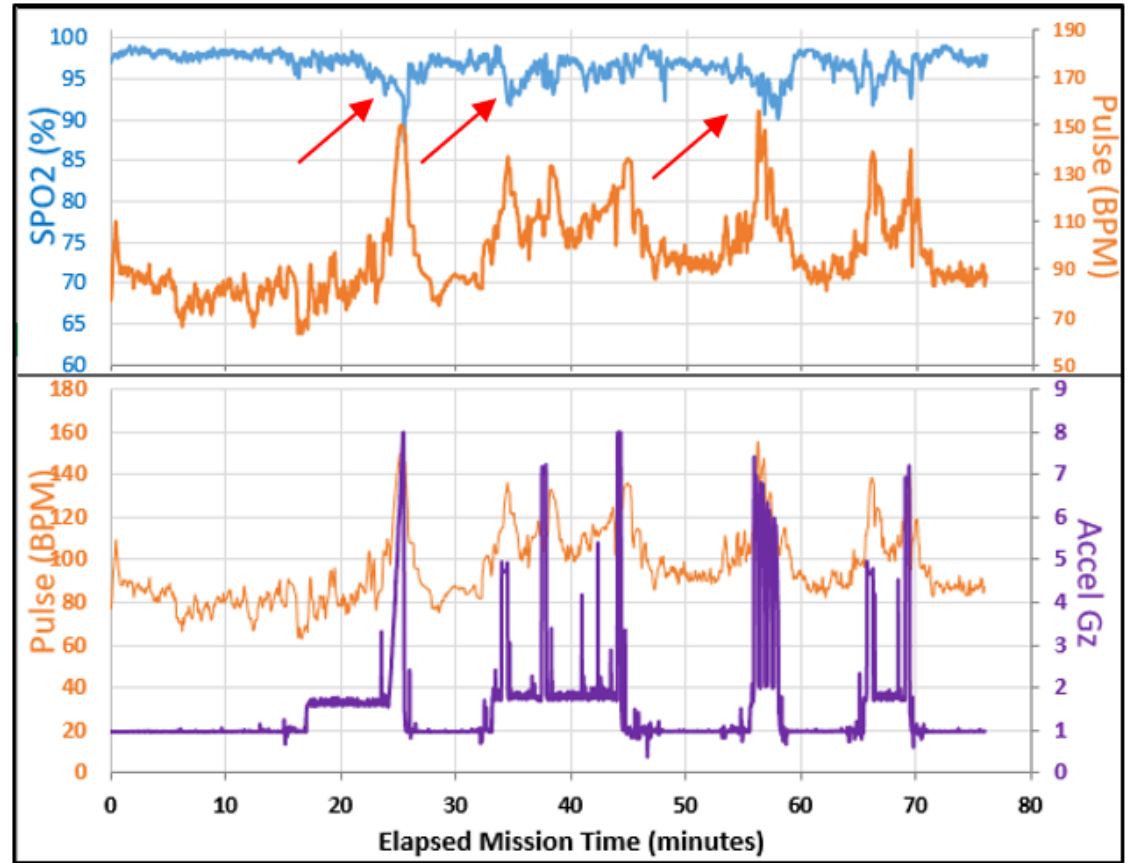
Figure 6. Manned-centrifuge full data as reported by SPYDR for a test subject simulating high-acceleration flight. Note decreases in blood oxygen saturation (SpO2) and increases in pulse rate commensurate with high-acceleration exposures (red arrows). The presence of a pulsatile waveform suggests that blood is flowing, yet decreased oxygen saturation indicates reduced perfusion which typically pre-empts a G-induced Loss of Consciousness (G-LOC).